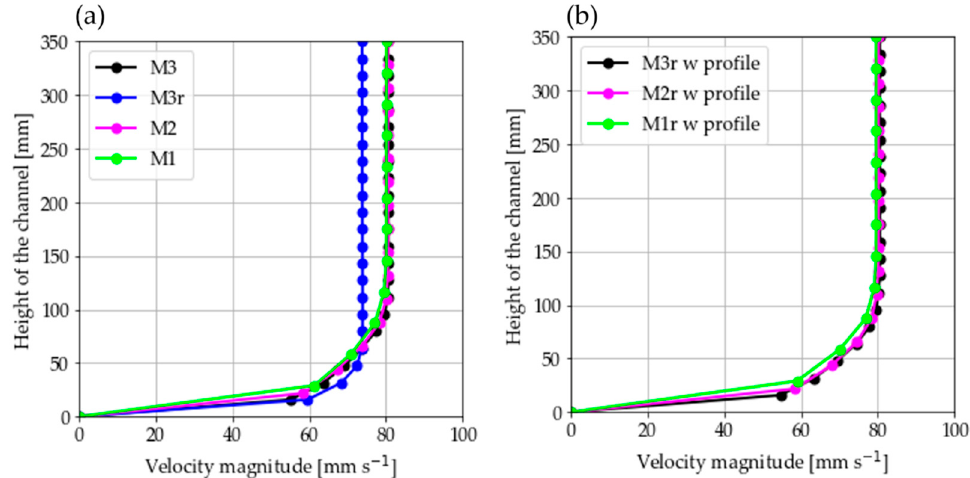
Figure 5. Vertical velocity profiles of water: ( a ) comparison between three mesh densities for the full domain and the fine mesh of the reduced domain; ( b ) comparison between three mesh densities of the reduced domain with a velocity profile boundary condition.